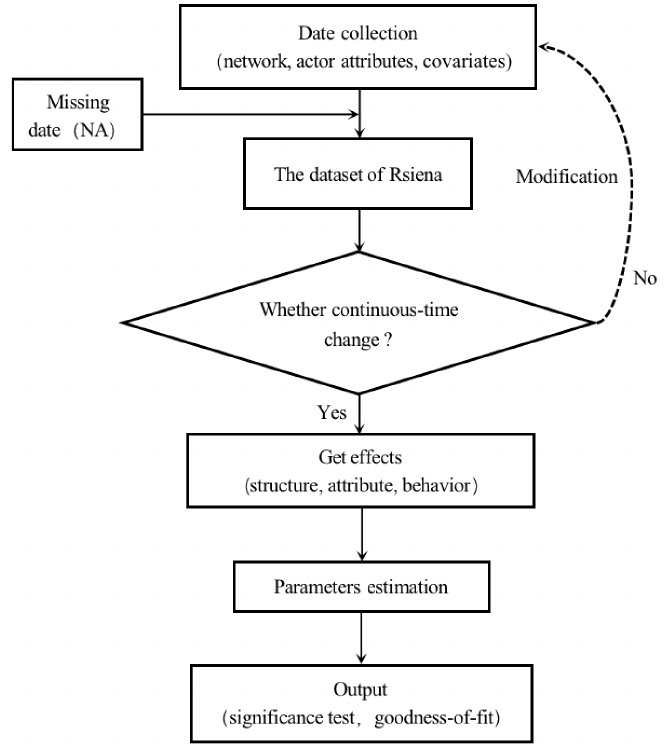
Figure 1. The procedure for the stochastic actor-oriented model (SAOM).